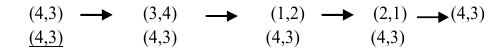
Table 3. Pay-off matrix for the non-cooperative game.